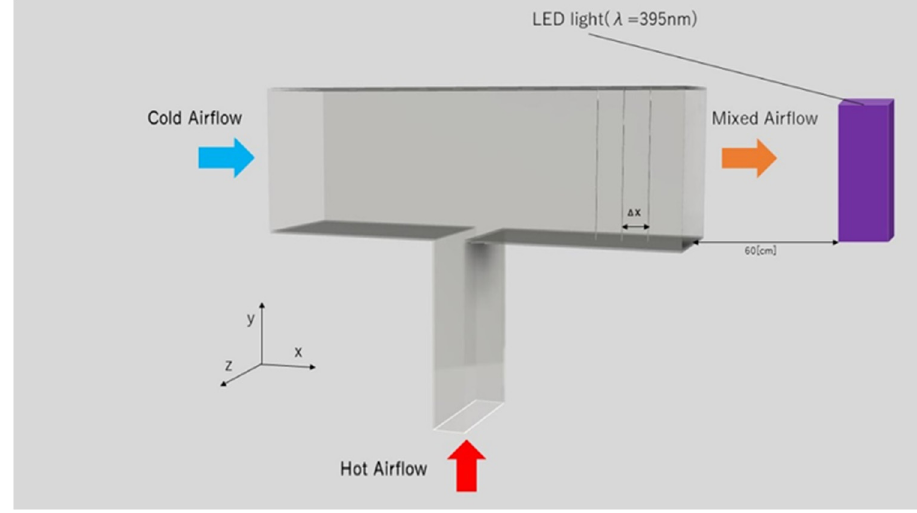
Figure 2. Experimental setup.